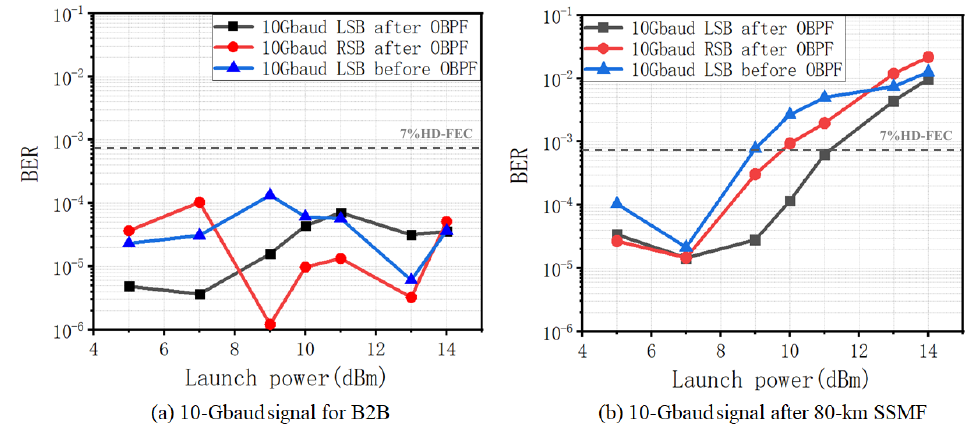
Figure 5. BER versus launch power. ( a ) 10 Gbaud for B2B; ( b ) after 80 km SSMF transmission.